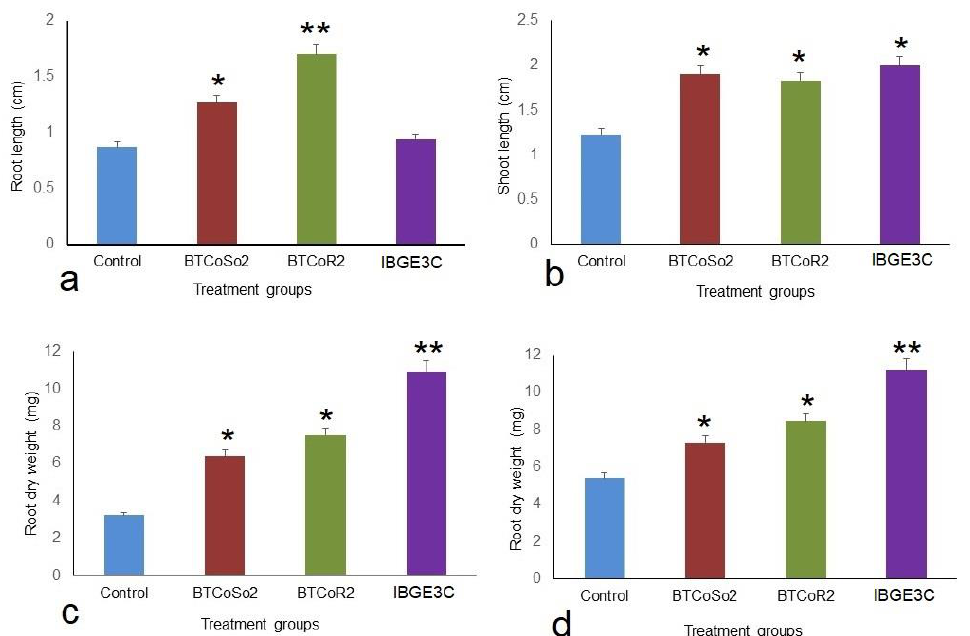
Figure 5. Effects of bacterial isolates on ( a ) root length; ( b ) shoot length; ( c ) root dry weight, and ( d ) shoot dry weight of BRRI dhan29 rice seedlings under 1% salinity. The IBGE3C was identified as Brevibacterium sediminis . From left to right, treatments are indicated under columns. Results are expressed in relative length and dry weight compared to control where values are means and bars indicate standard errors ( n = 3 ). * p < 0.05 and ** p < 0.005 as compared to control. Table 2. Effects of bacterial isolates on seedling growth of BRRI dhan29 at 1% salinity. Values are mean ± standard error (significance level α =